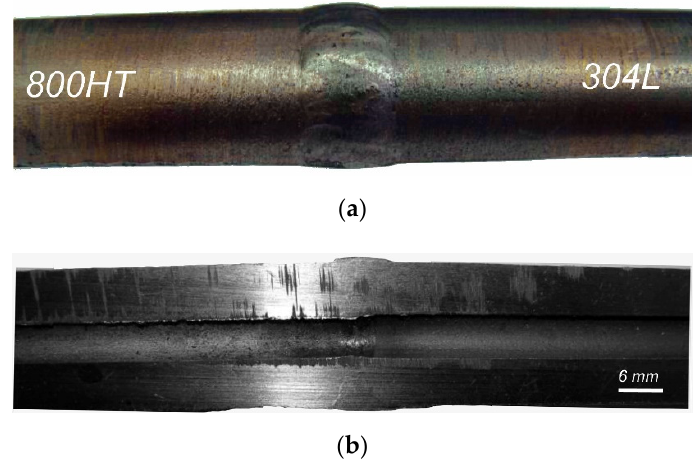
Figure 3. Example of a specimens ( a ) view from the face; ( b ) cross-section.